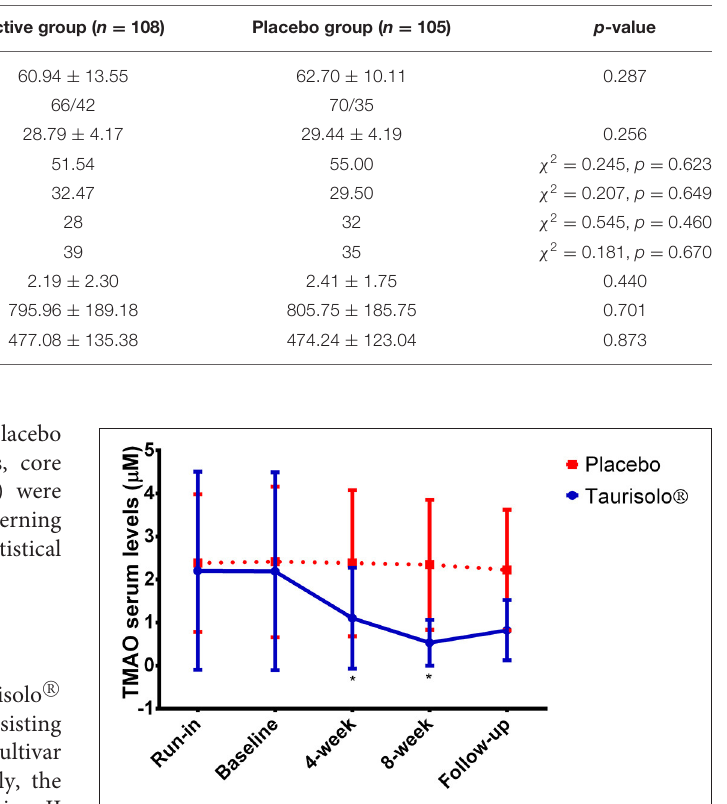
FIGURE 2 | Graphical representation of the TMAO serum levels at the different time points . Values are expressed as mean ± standard deviation. Statistical significance was calculated with Student’s t -test; p < 0.05 was considered as significant. * P < 0.0001, Taurisolo ® group, compared to